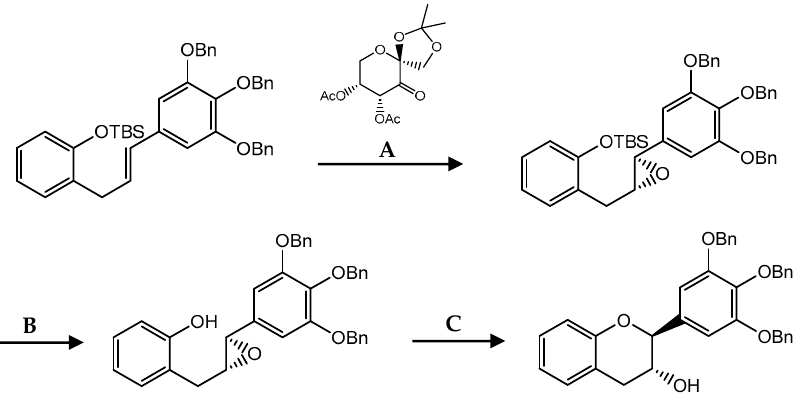
Figure 20. Flavanols synthesis by Shi’s asymmetric epoxidation. ( A ) Oxone, MeCN, DMM, phosphorus buffer; ( B ) TBAF, AcOH, THF; ( C ) CSA, CH 2 Cl 2 .